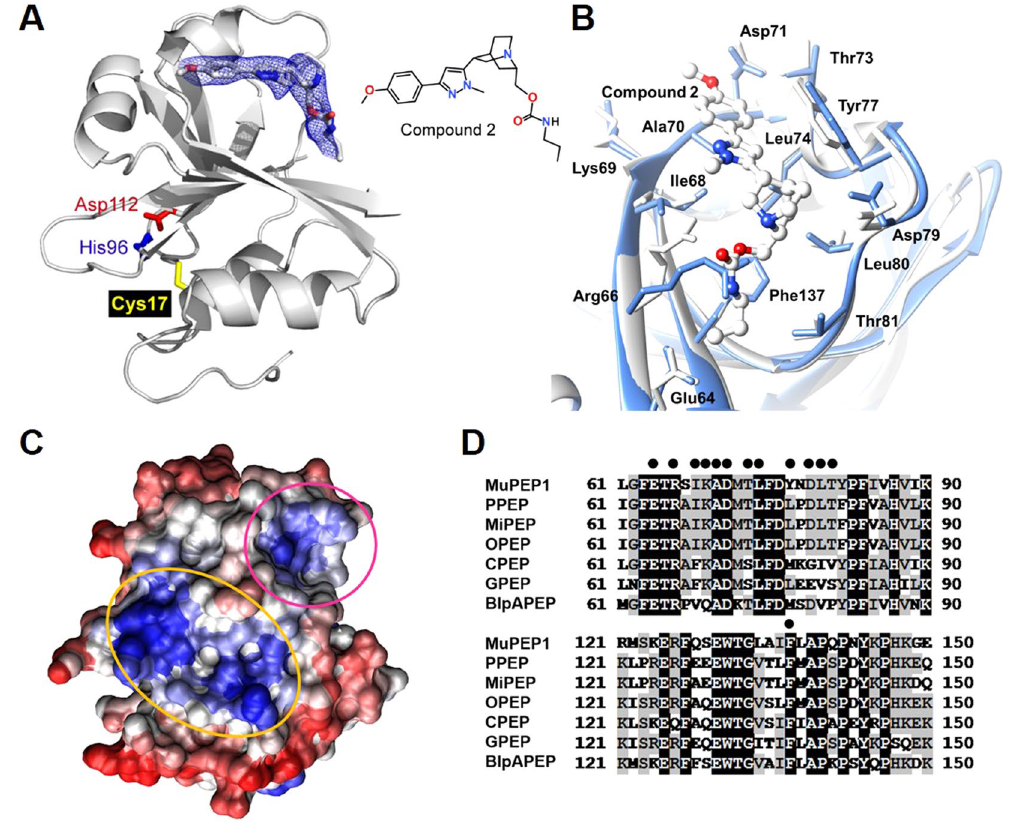
Figure 3. Structure of the MuPEP1–Compound 2 Complex and the Compound 2-binding Site. ( A ) The crystal structure of the tMuPEP1–Compound 2 complex and an | F o | − | F c | omit map. The electron density is shown around the compound and contoured at a level of 2.5 σ (blue mesh). The side chains of the catalytic triad residues, Cys17 (yellow), His96 (blue), and Asp112 (red), are shown as sticks. The oxygen and nitrogen of Compound 2 are colored red and blue, respectively. ( B ) Superimposition of the structures of the free tMuPEP1 (cyan) and the tMuPEP1-Compound 2 complex (white). The residues that interact with Compound 2 are shown as sticks and are labeled. The oxygen and nitrogen of Compound 2 are colored red and blue, respectively. ( C ) Surface representation of the result of the HotPatch program performed on MuPEP1 33 . The hydrophobic region is colored blue, and the hydrophilic region is red. The hydrophobic concave surface that is the binding site for the N-terminal helix of ComC is encircled by an orange line, and the inhibitor binding pocket is encircled by a magenta line. ( D ) Amino acid sequence alignment of PEPs from different species of Streptococcus ComA and the peptidase domain of S. pneumoniae BlpA. The completely identical amino acid residues and the partially identical amino acid residues (at least four out of seven sequences) among PEP sequences are shaded black and gray, respectively. MuPEP1, S. mutans PEP; PPEP, S. pneumoniae PEP; MiPEP, S. mitis PEP; OPEP, S. oralis PEP; CPEP, S. cristatus PEP; GPEP, S. gordonii PEP; and BlpAPEP, the peptidase domain of S. pneumoniae BlpA. Dots indicate 13 amino acid residues that are in close contact with Compound 2 in the structure of the tMuPEP1- Compound 2